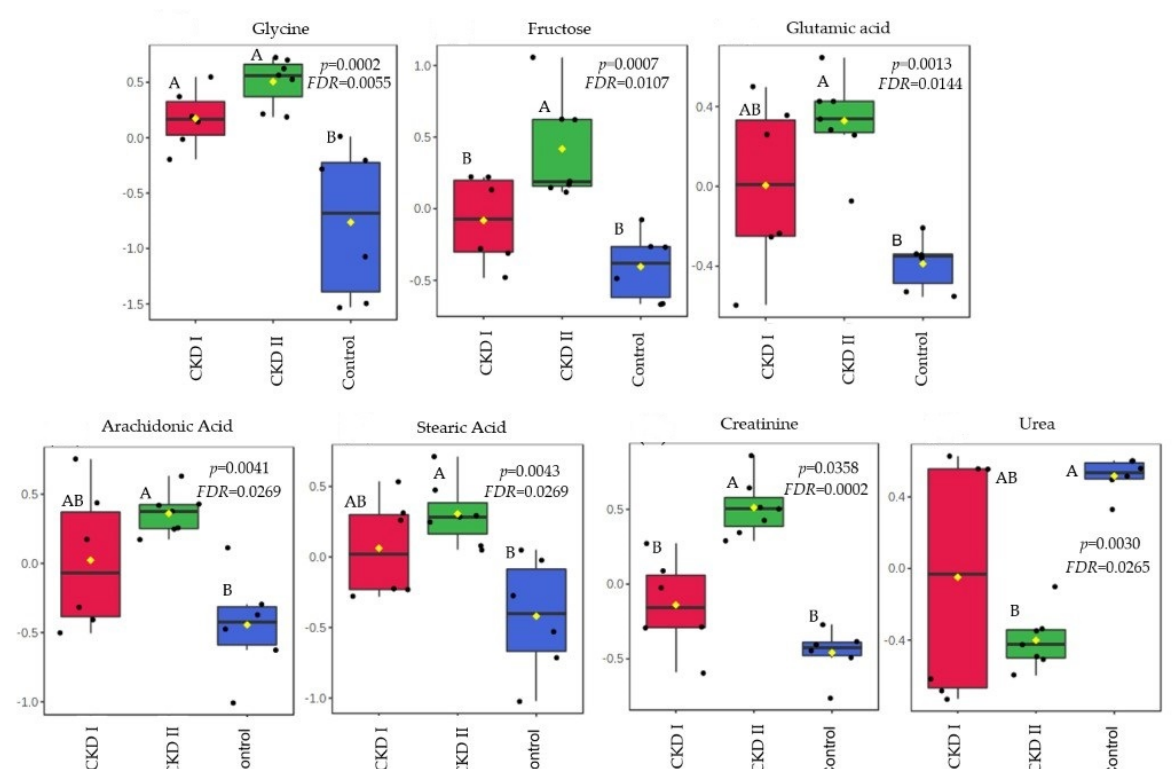
Figure 4. Metabolites that significantly differed among groups after 60 days of consumption of the renal diet. CKD I = CKD cats stage 1; CKD II = CKD cats stage 2; Control = control group (healthy animals).